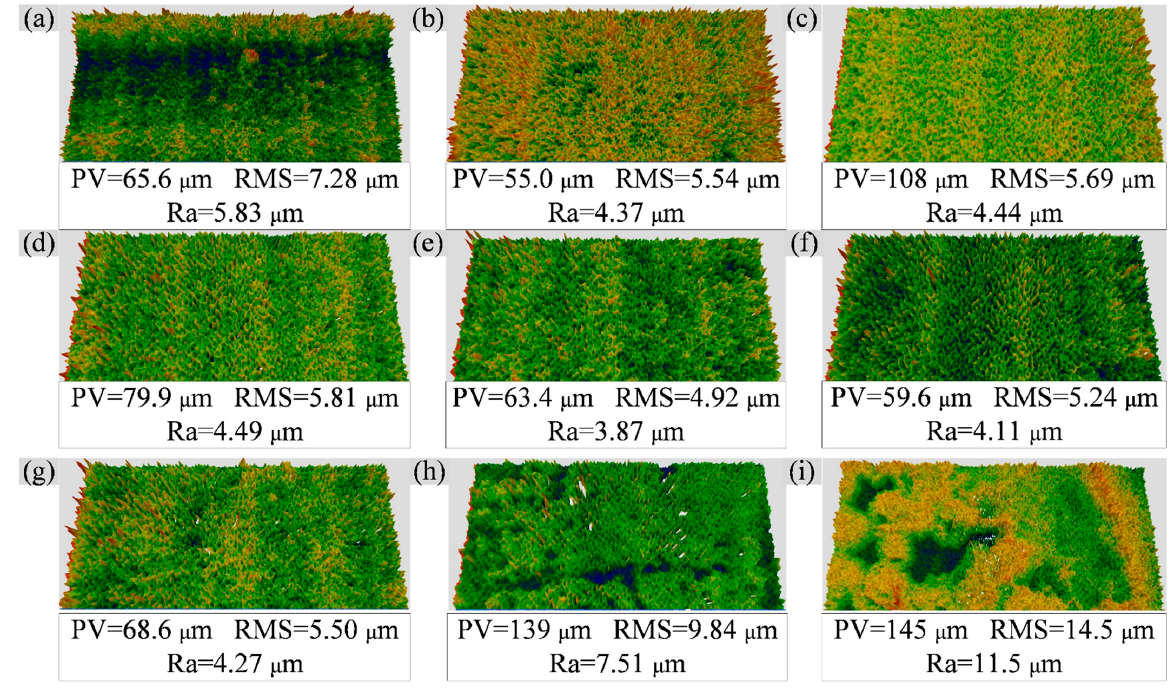
Table 3. Coating surface stats parameters.